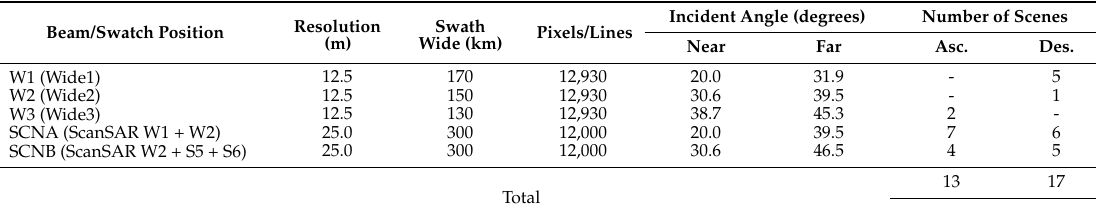
Table 1. Summary of the RADARSAT-2 image data properties used in this